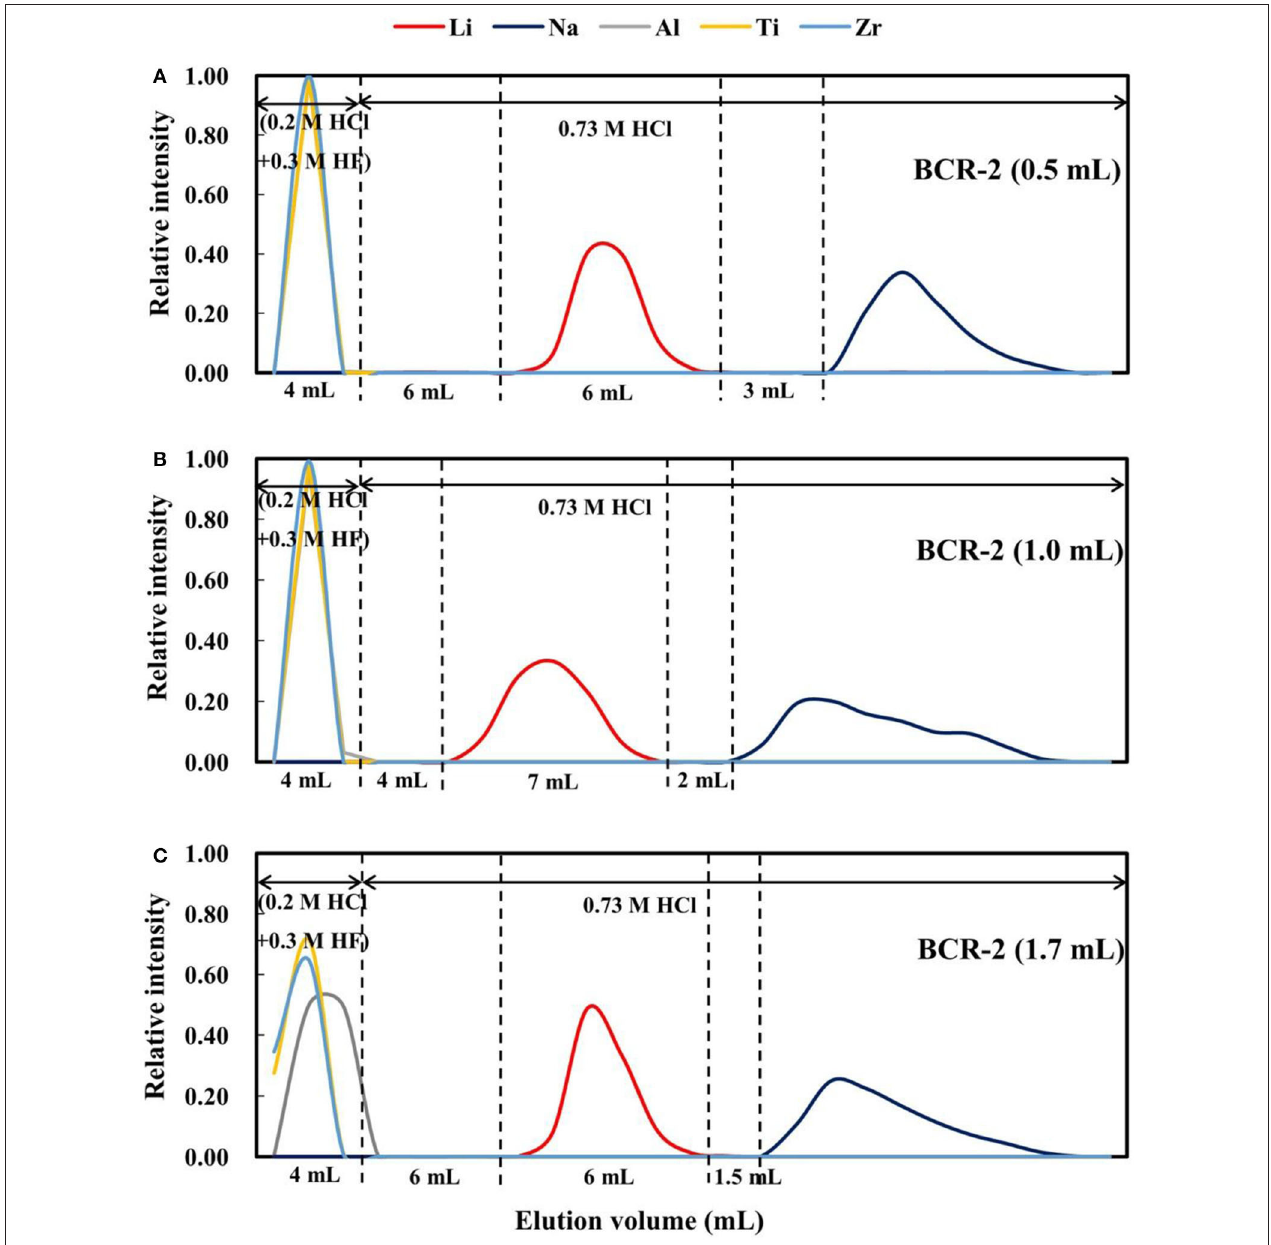
FIGURE 7 | Elution curves for BCR-2 with different loading volumes on AGMP-50 resin. (A) 270 ng Li in 0.5mL of 2.5M HCl; (B) 270 ng Li in 1.0mL of 2.5M HCl; (C) 270 ng Li in 1.7mL of 0.73M HCl.